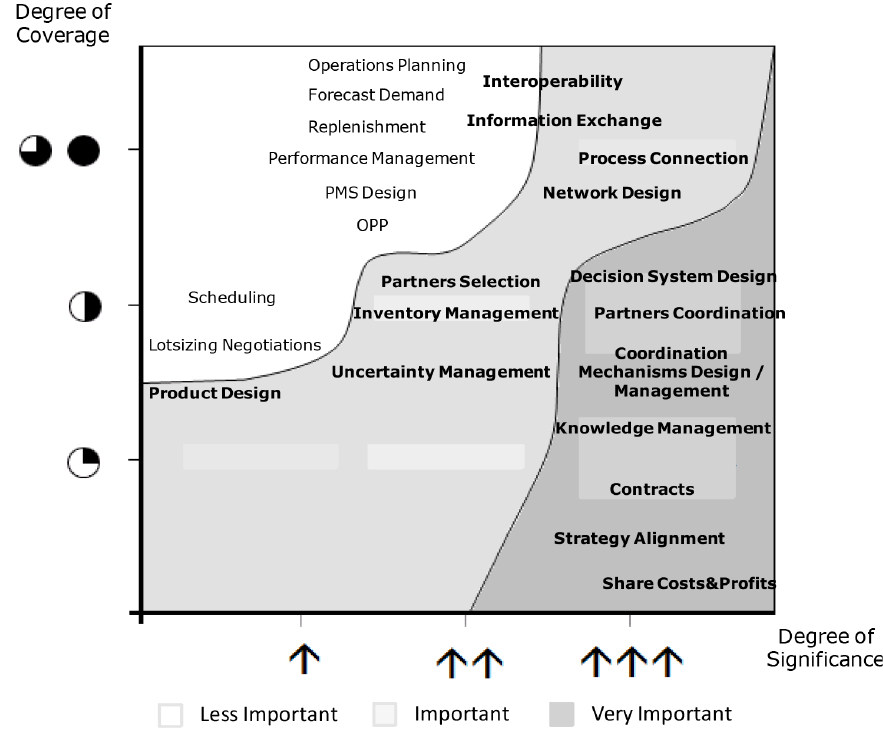
Figure 3. Relevant Problems to provide